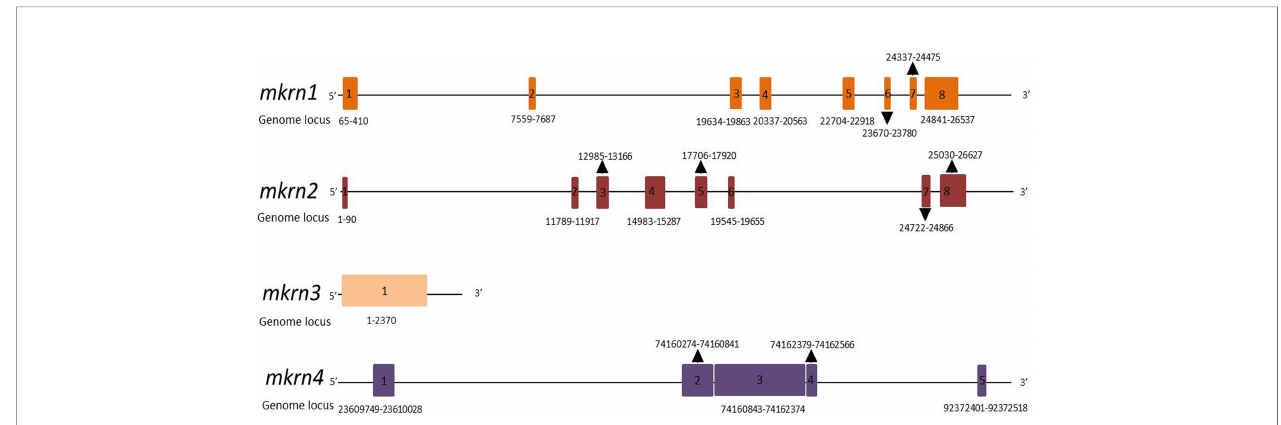
FIGURE 1 | Schematic gene structures of human mkrn 1, mkrn 2, mkrn 3 and mkrn 4 loci. Exons are represented as boxes. Number and locus of exons in genome are